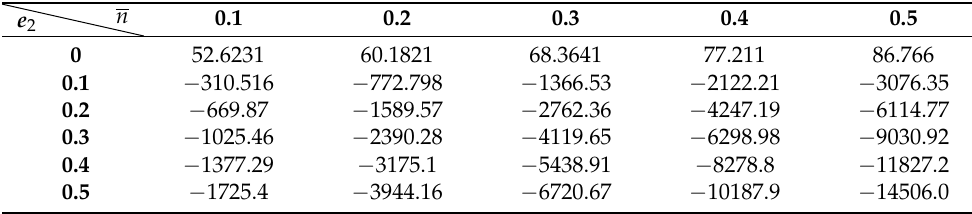
Table 6. Values for C f P r = 0.7, S c =